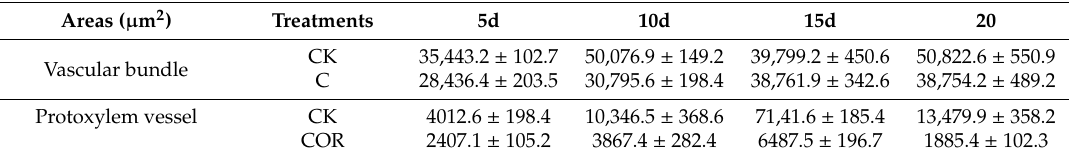
Figure 5. Scanning electron microscopy of the transverse sections of vascular bundles in the middle of the third basal internode at different numbers of days after COR was sprayed onto foliar surfaces in maize inbred line B73 plants. PX: protoxylem vessel; MX: metaxylem vessel; PH: phloem tissue; VBS: vascular bundle sheath; CK: control treatment; COR10: 10 µmol L − 1 COR-treatment. 5 d, 10 d, 15 d, and 20 d: respectively 5, 10, 15, and 20 days after COR treatment. Table 2. The effects of COR on the areas of the vascular bundles and protoxylem vessel in Figure 5.